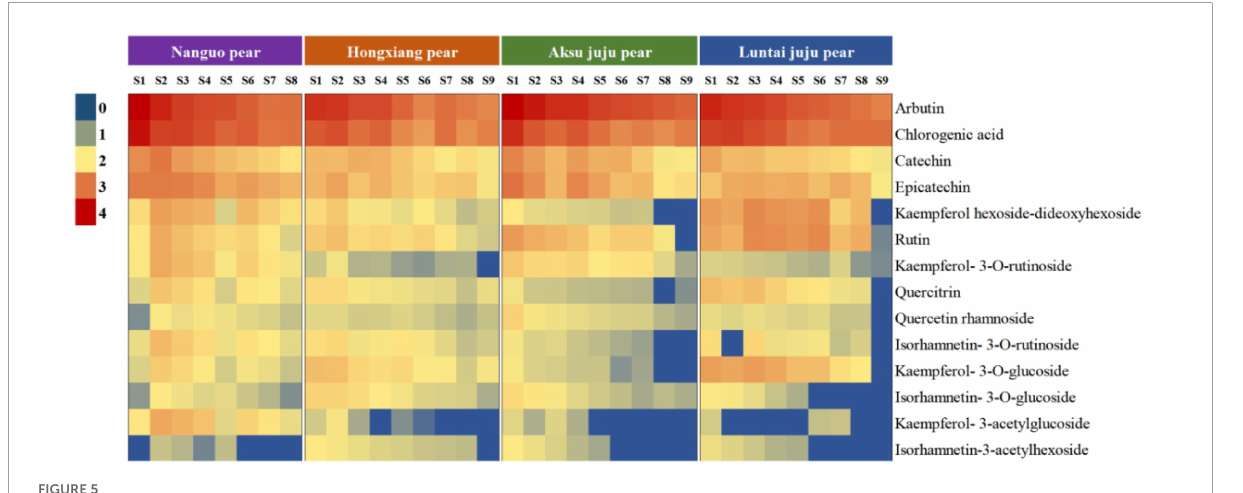
FIGURE5 Thermogram of four pear phenolic